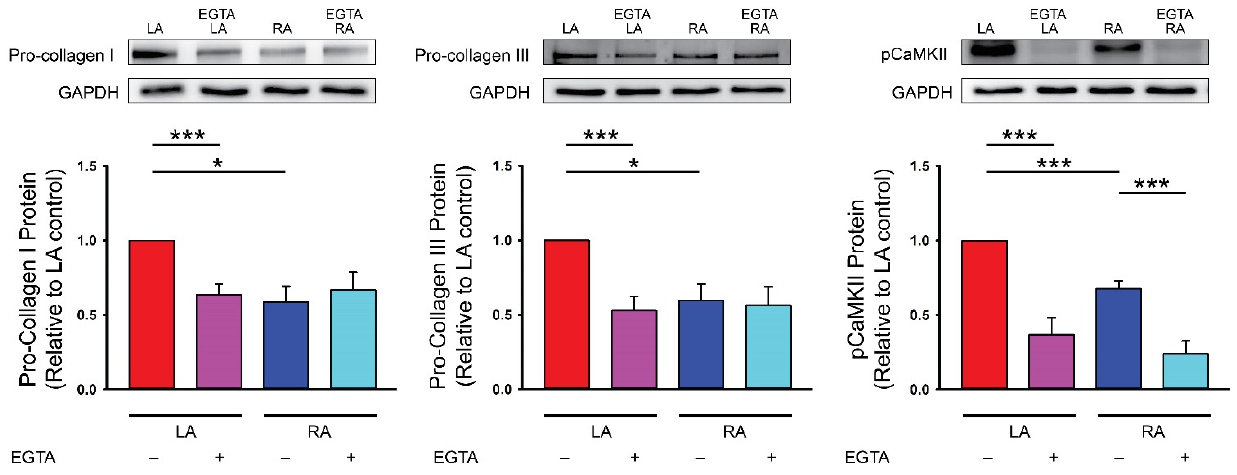
Figure 3. Ca 2+ entry on the diversity of the collagen production ability in the cultured passage 1 (P1) left atrium (LA) and right atrium (RA) fibroblasts from healthy rats. Photographs and averaged data of the pro-collagen type I (n = 6 independent experiments), pro-collagen type III (n = 6 independent experiments) and phosphorylated Ca 2+ /calmodulin-dependent protein kinase II (pCaMKII, n = 6 independent experiments) expression in LA and RA fibroblasts with or without 1 mmol/L ethylene glycol tetra-acetic acid (EGTA, an extracellular Ca 2+ chelator) for 48 h. GAPDH was used as a loading control. * p < 0.05, *** p < 0.005.